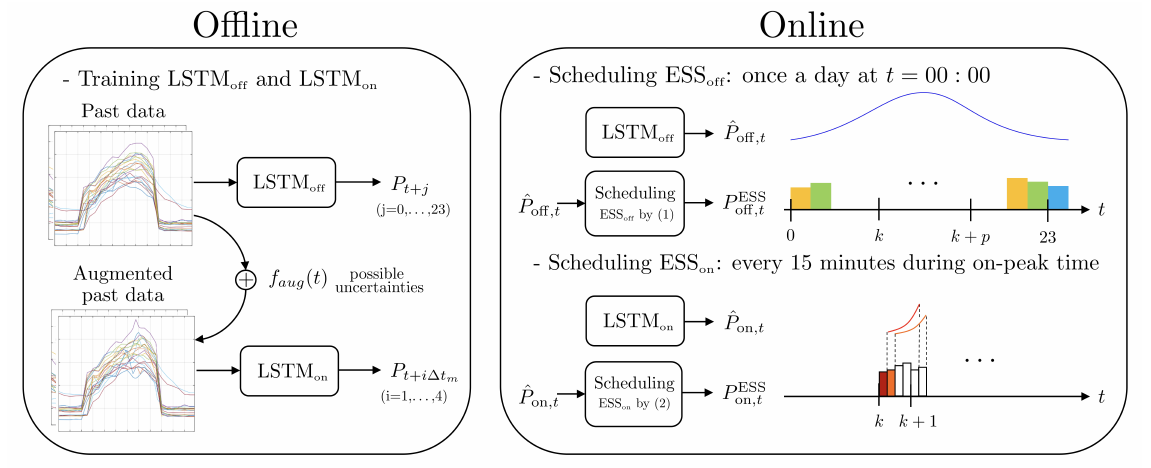
Figure 1. Structure of the proposed BEMS.